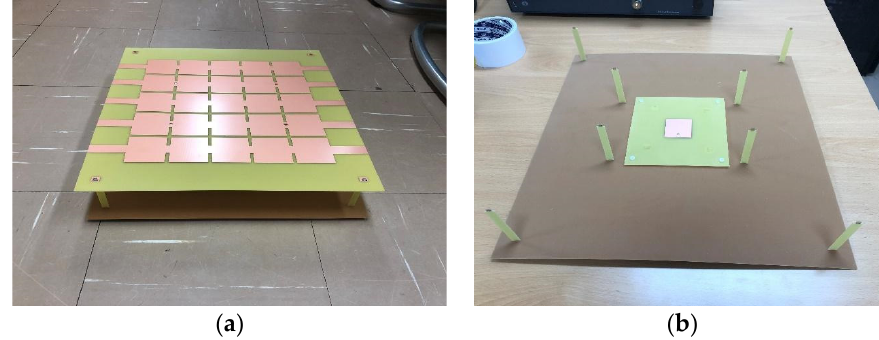
Figure 7. Constructed antenna: ( a ) complete structure, ( b ) patch antenna for feed.